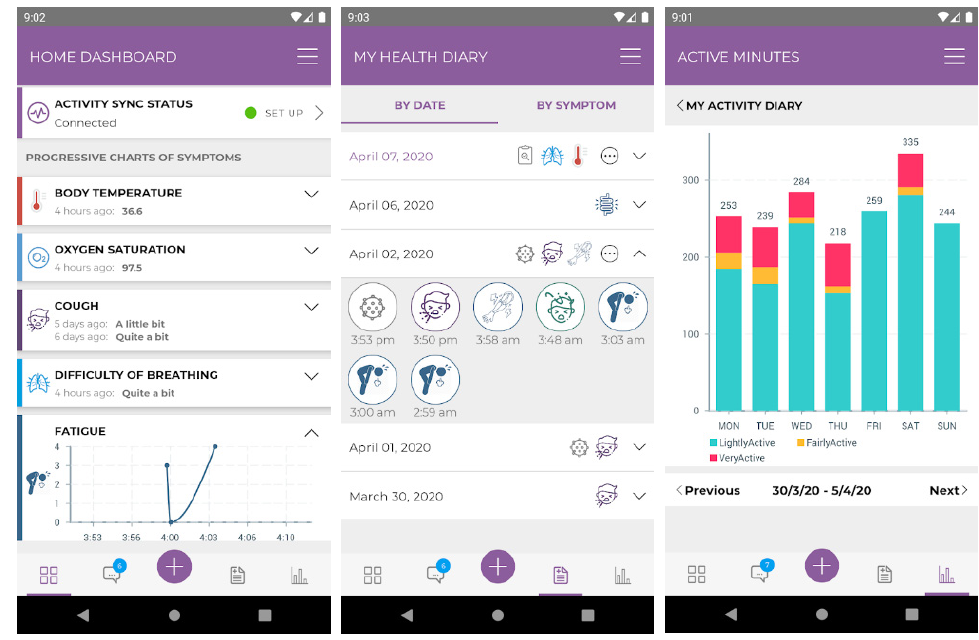
Figure 1. Healthentia mobile application—main screen, reported events and measurements.